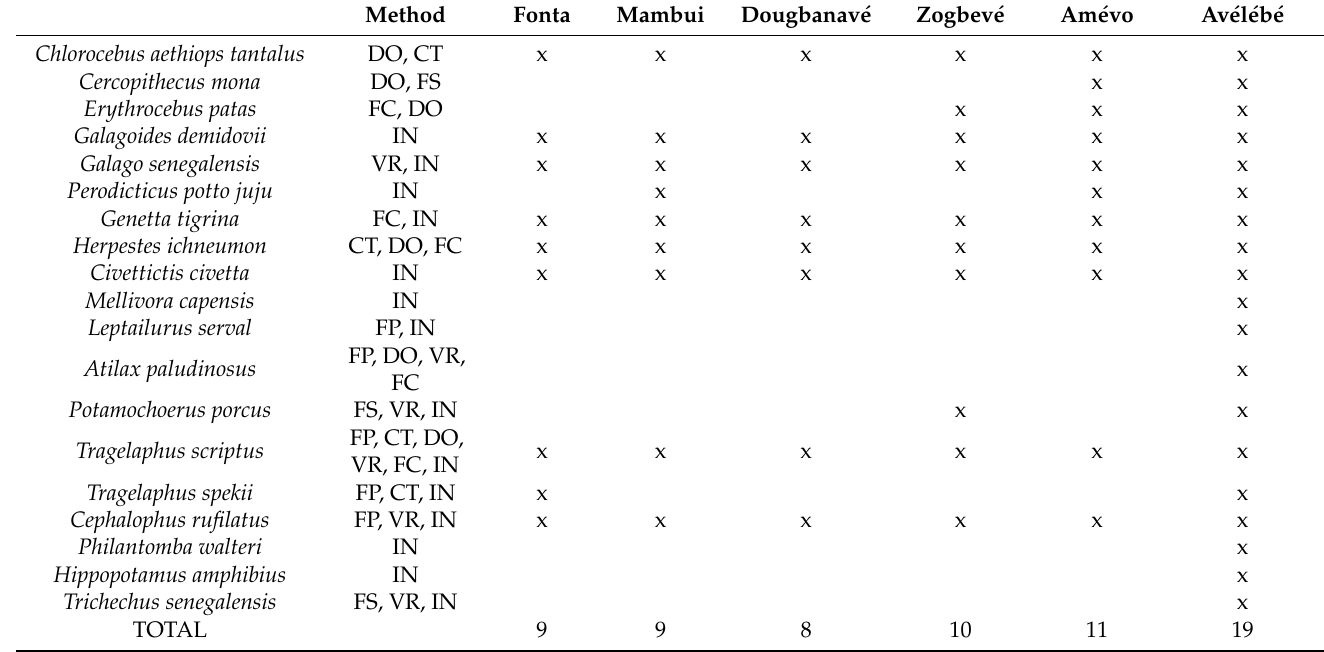
Table 1. Presence of the various species of mammals in the various forest blocks at the study area and details of the method by which each species was recorded.